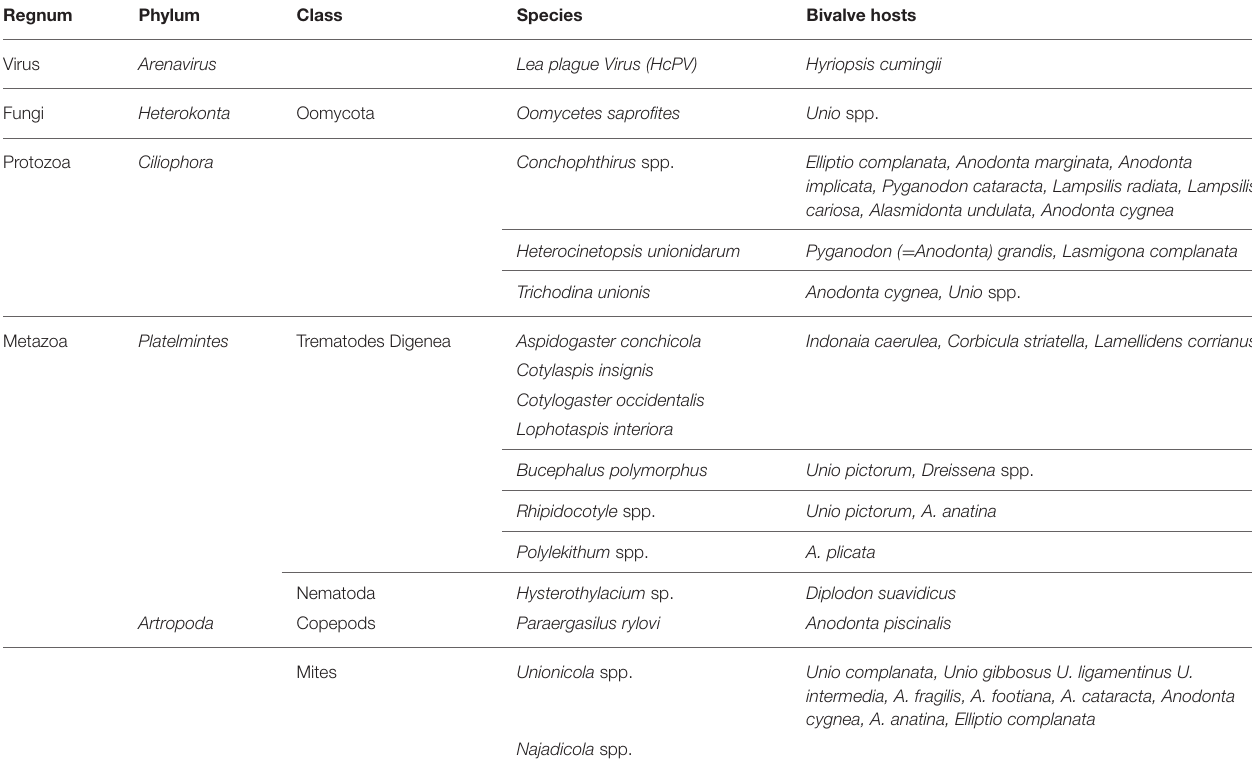
TABLE 1 | Pathogens (virus, fungi, protozoa, and metazoa) described in